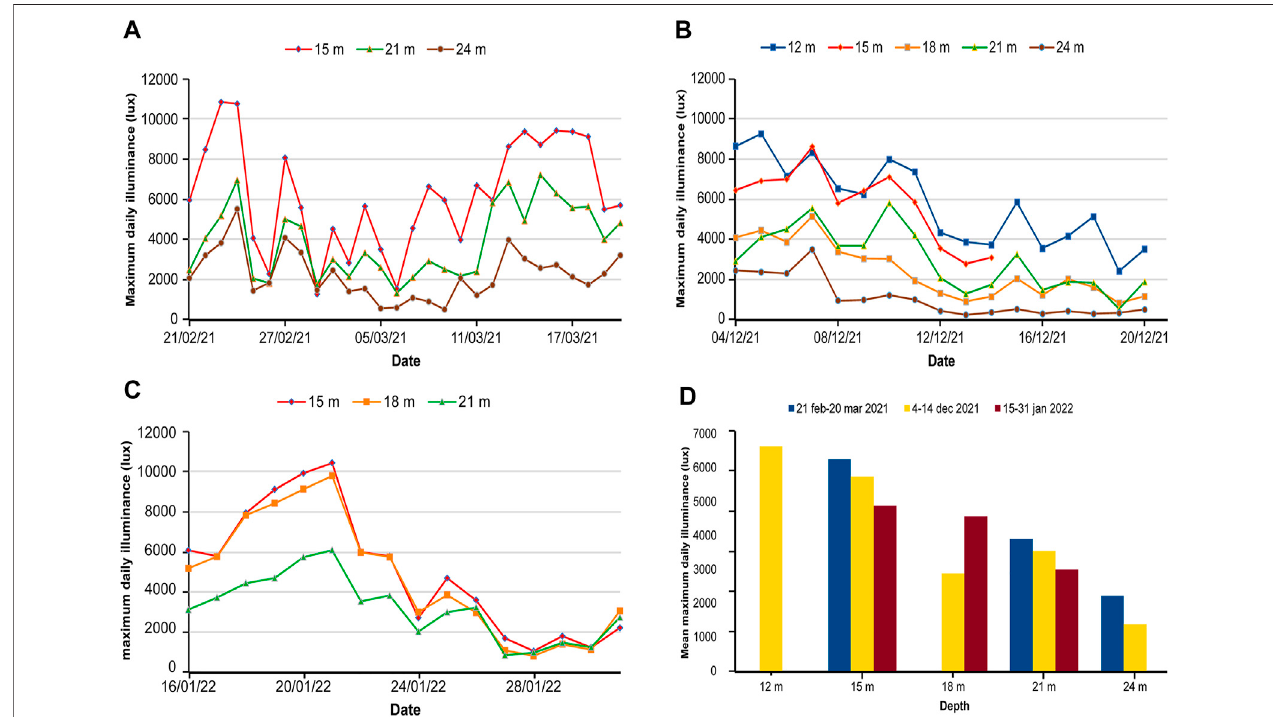
FIGURE 4 | Daily maximum illuminance from (A) 21 February to 21 March2021 and (B) 4 to 20 December 2021, (C) 15 to 31 January 2022 and (D) variation of mean maximum illuminances by depth.